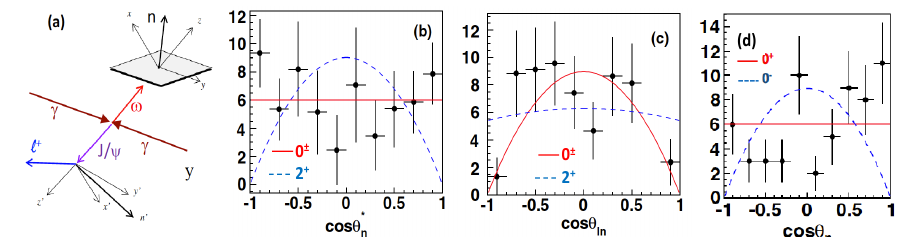
Figure 2. a) Directions used in the BaBar study of γγ → ω J /ψ , where ω → π + π − π 0 and J /ψ → (cid:96) + (cid:96) − . b) Compar- ison of the cos θ ∗ n distribution with J P = 0 ± (solid red) and 2 + (dashed blue) expectations. c) The corresponding plot for cos θ ln . d) The cos θ n distribution with expectations for 0 + in solid red and 0 − in dashed blue. (From ref. [6].)